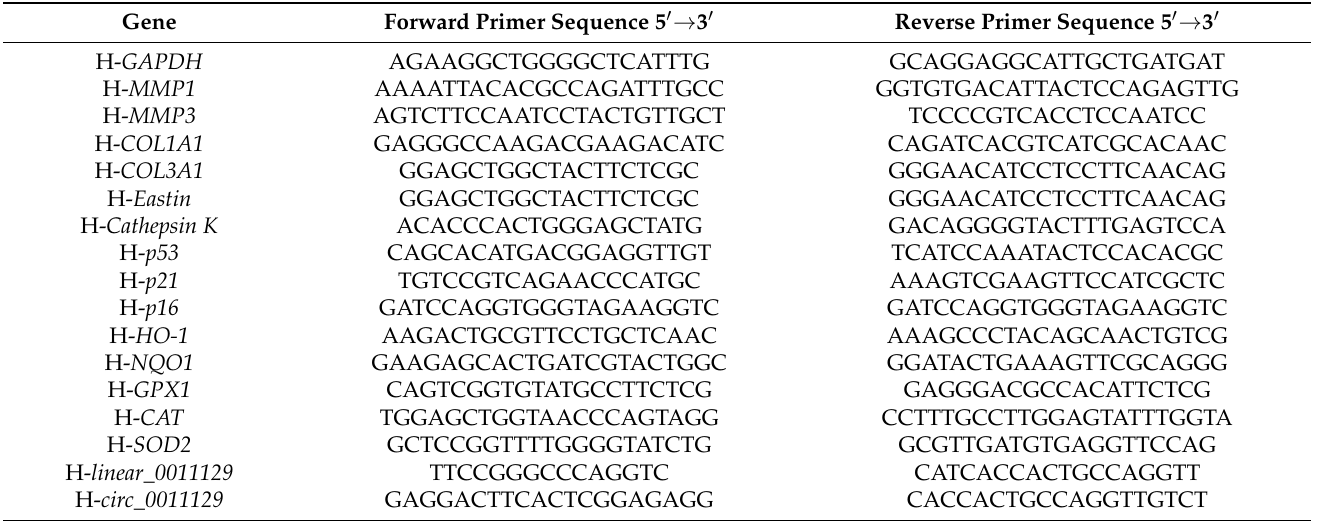
Table 1. The sequences of the qPCR primers. Gene Forward Primer Sequence 5 (cid:48) → 3 (cid:48) Reverse Primer Sequence 5 (cid:48) → 3